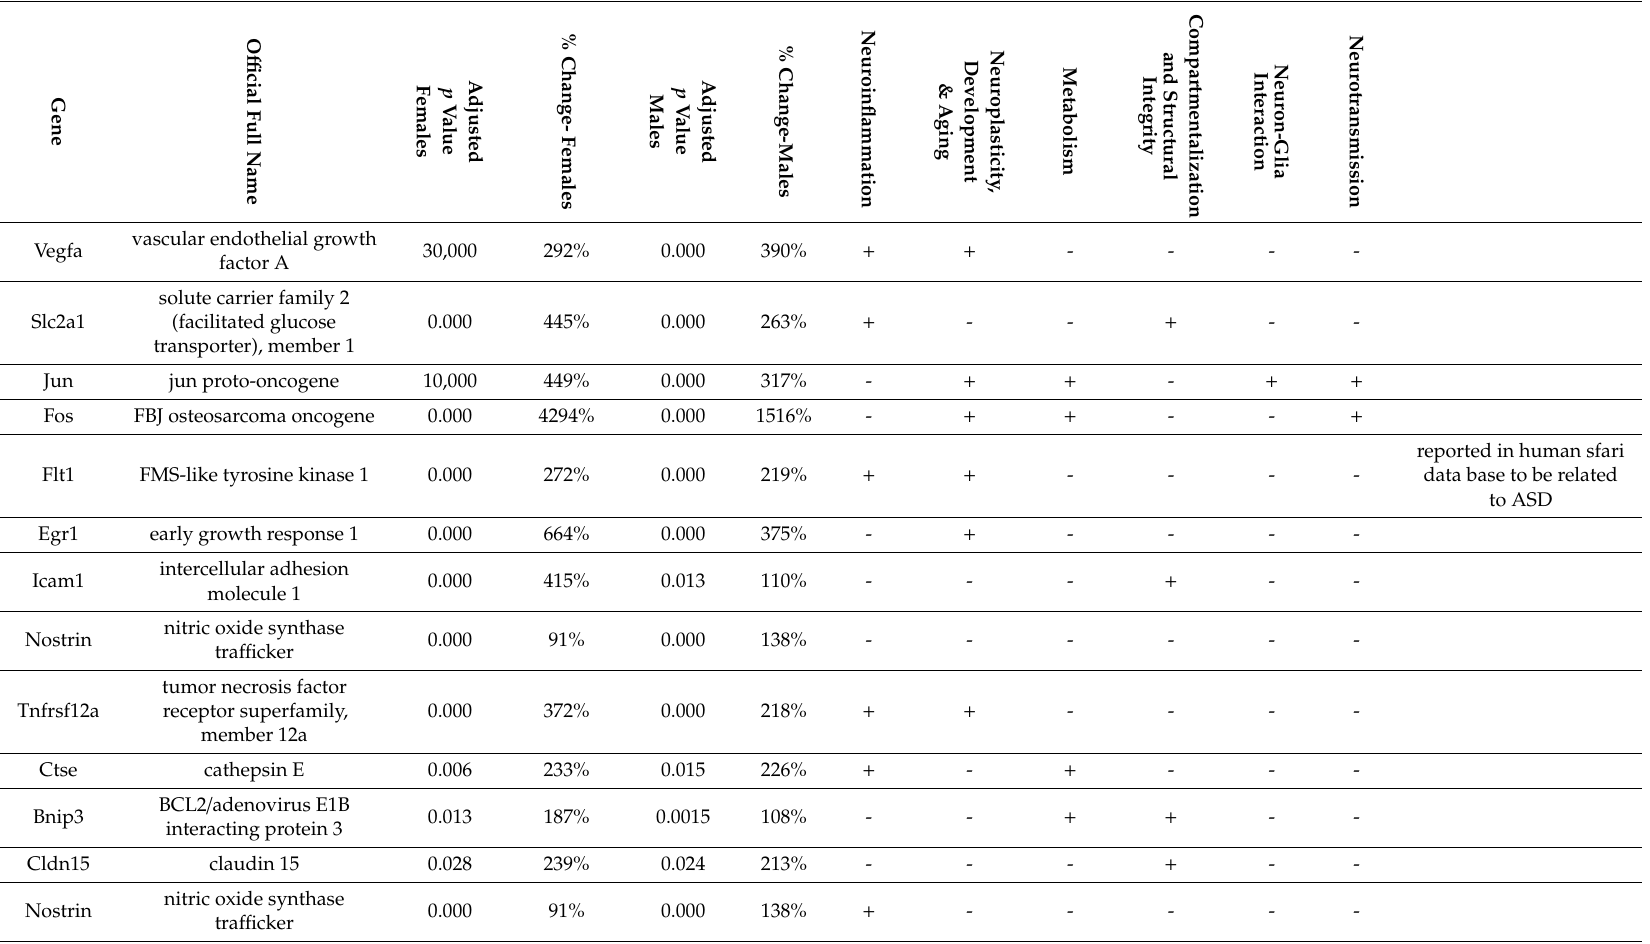
Table 3. Genes changed at least by 100% in both genders after SAMe administration